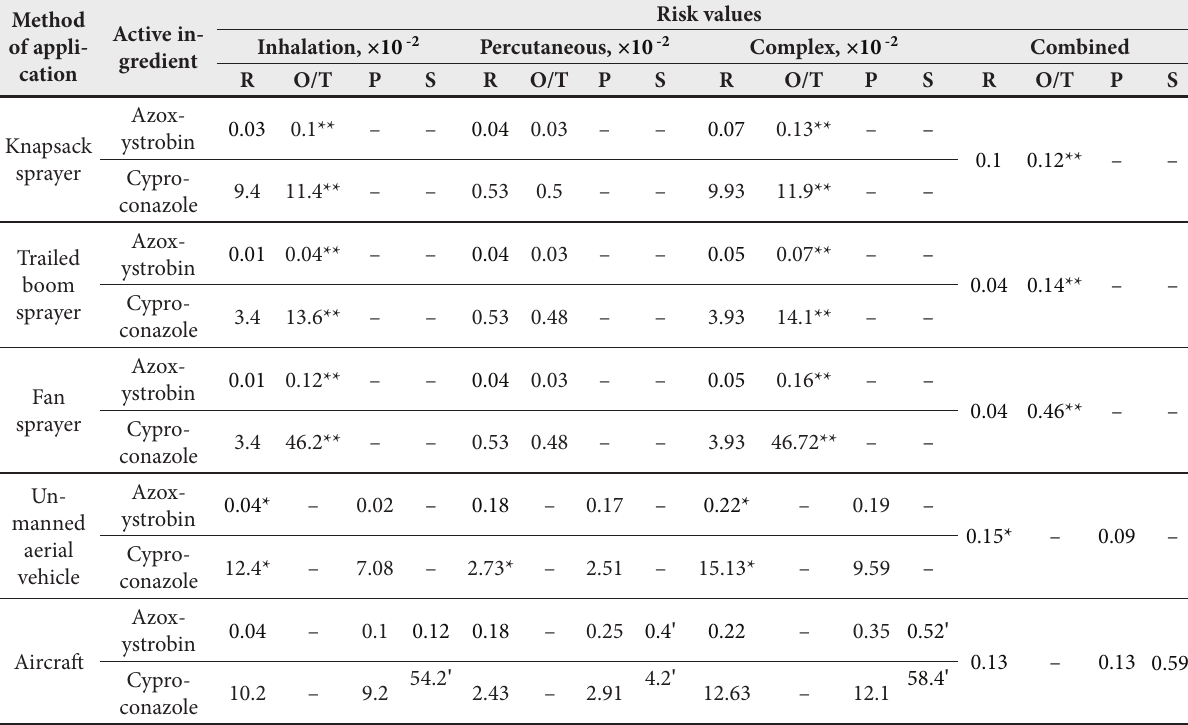
Values of potential risk of dangerous influence of the Amistar Extra 280 SC formulation when applied by different methods of